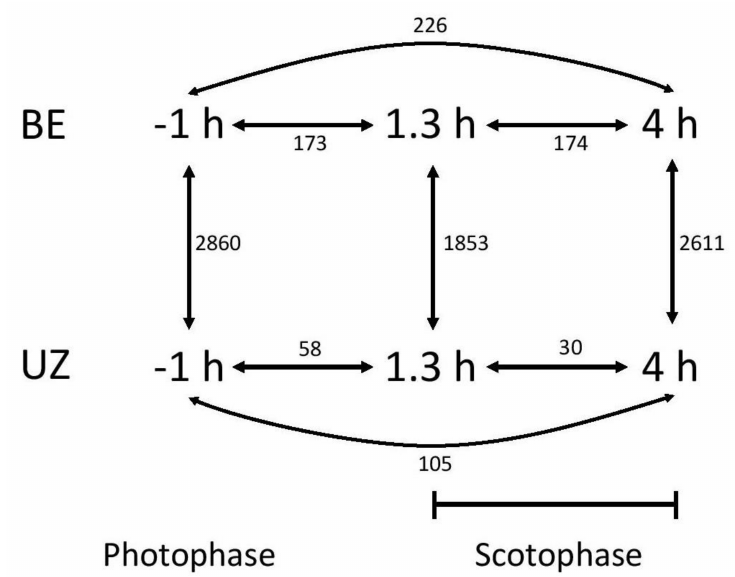
Figure 2. Schematic of specific contrasts tested in differential expression analysis. Within strain, comparisons were made between each pair of time points (photophase vs. 1.3 h of scotophase, photophase vs. 4 h of scotophase, and 1.3 vs. 4 h of scotophase). Between-strain, comparisons were made at each time point (BE vs. UZ). Numbers shown are total numbers of differentially expressed transcripts in each